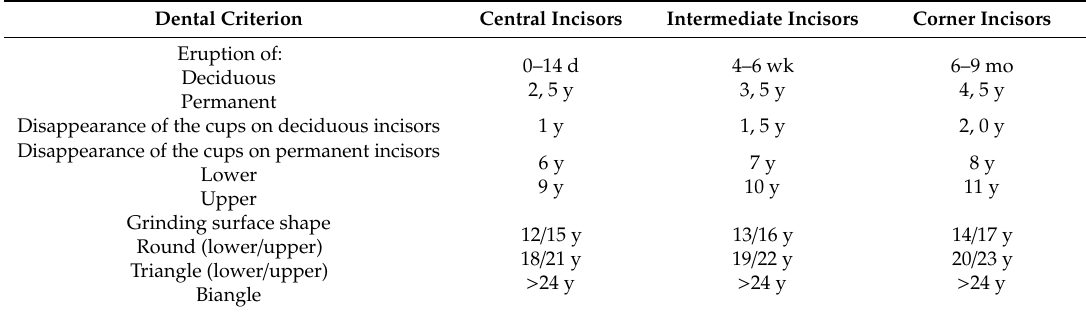
Table 1. A method for assessing the horse’s age based on the appearance of incisors [12].